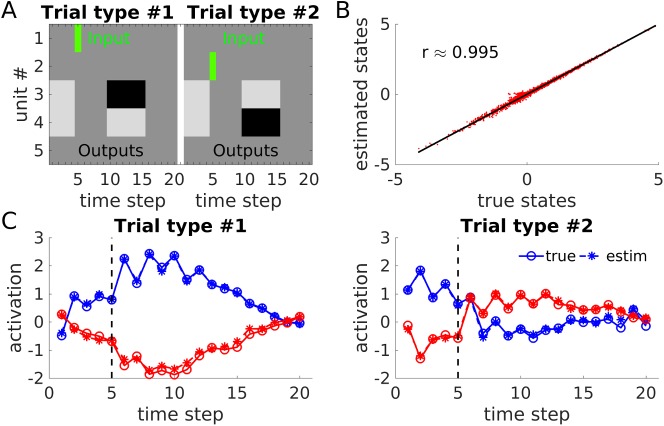
State estimation for ‘working memory’ example when true parameters were provided.(A) Setup of the simulated working memory task: Stimulus inputs (green bars, sit = 1, and 0 otherwise) and requested outputs (black = 1, light-gray = 0, dark-grey = no output required) across the 20 time points of a working memory trial (with two different trial types) for the 5 PLRNN units. (B) Correlation between estimated and true states (i.e., those from which the observations X were generated) across all five state variables and T = 800 time steps. Bisectrix in black. (C) True (open-circle/ solid lines) and estimated (star-dashed lines) states for output units #3 (blue) and #4 (red) when s15 = 1 (left) or s25 = 1 (right) for single example trials. Note that true and inferred states are tightly overlapping in this low-noise example (such that the ‘stars’ often appear on top of the ‘open circles’). Although working memory PLRNNs may, in principle, be explicitly designed (see text), here a 5-state PLRNN was first trained by conventional gradient descent (real-time recurrent-learning [50]) to perform the task in A, to yield more ‘natural’ and less uniform ground truth states and parameters. Here, all θi = 0 (implying that there can only be one stable fixed point). See Matlab file ‘PLRNNwmParam.mat’ and Fig 4 for details on parameters.